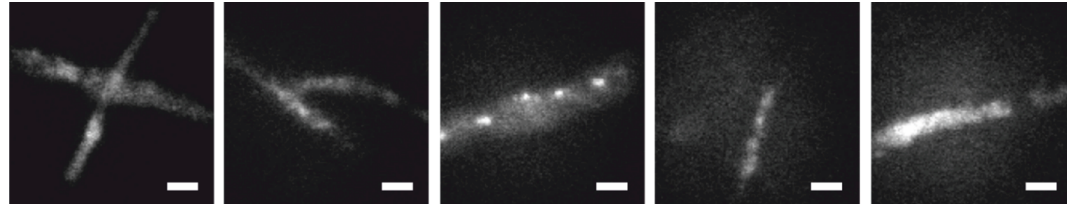
Figure 3. Representative images of T. atroviride wild-type hyphae from the five movies used as autofluorescence models. Scale bars = 3 µm.